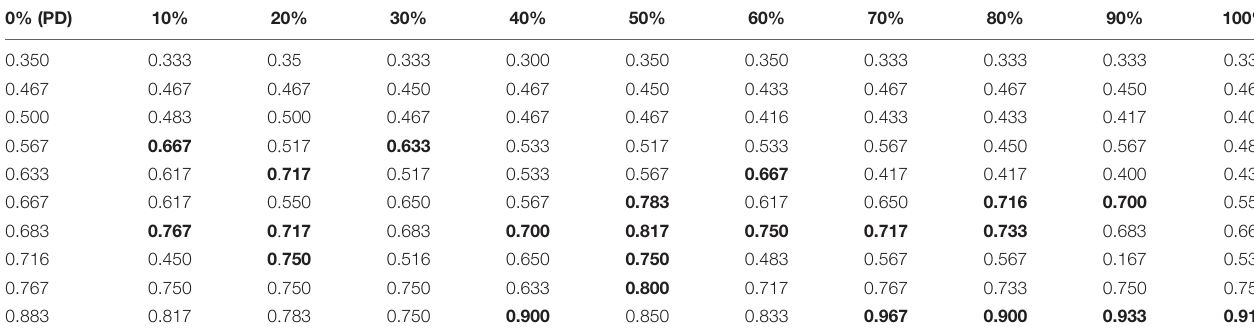
Data in bold means that the stimulus is